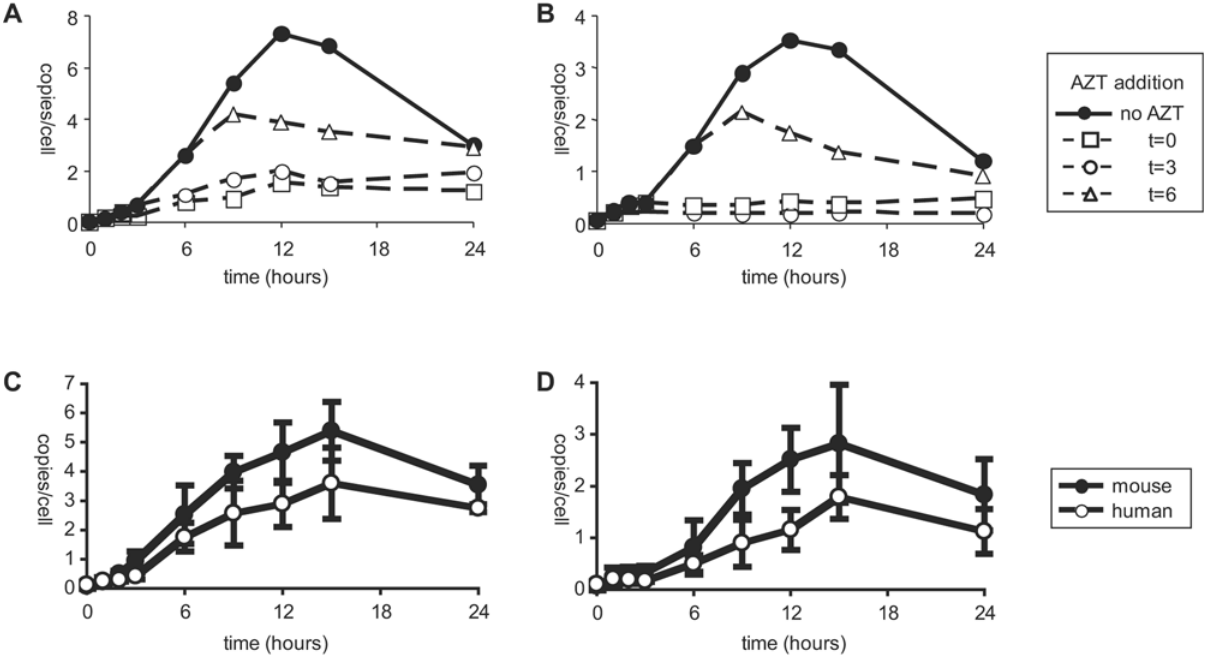
Figure 2. Primary CD4 + T cells from hCyclin T1 mice support efficient reverse transcription of HIV-1. (A) Kinetics of early reverse transcription products in mouse T cells. MACS purified CD4 + T cells from three individual hCyclin T1 mice were activated for 36 h by anti-CD3/28. Cells were then spin infected with benzonase-treated VSVG-pseudotyped HIV-GFP (MOI=2). 3 h post infection, cells were washed to remove virus and replated on anti-CD3/28. At different time points, cells were collected, washed and frozen down. DNA was isolated by phenol extraction and Real Time PCR analysis was preformed. To show the de novo formation of reverse transcription products, AZT (15 m M) was added at different time points and cells were collected as above starting from the next time point (Dashed lines). Real Time-PCR was performed using primers and probes specific for 18S rRNA (for cell number) and R-U5 (for early reverse transcription product). The copy number of reverse transcription product was then normalized to cell number and displayed as copy number per cell. (B) Kinetics of late reverse transcription products. Samples from panel A were subjected to Real Time-PCR using primers and probes specific for U5-Gag. (C, D) Activated CD4 + T cells from three mice were infected and analyzed for early (panel C) and late reverse transcription (panel D) products as described in panel A. For comparison, PHA activated human PBMC CD4 + T cells from three donors were infected and analyzed in parallel. All values represent the arithmetic means 6 SD. Data represent two independent experiments, each with cells from three human donors or three